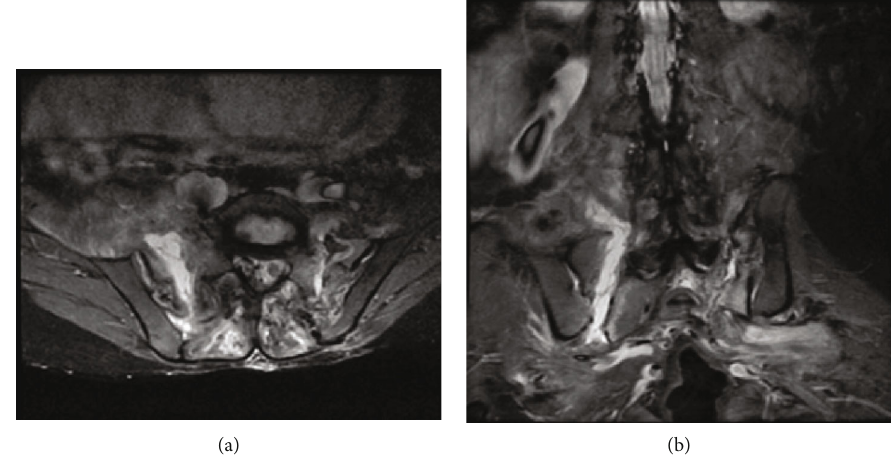
Figure 3: MRI showed an extensive oedema of the posterior paraspinal muscles bilaterally from L4 to S2 levels and di ff use marrow oedema of the sacrum. A large collection in the right posterior paraspinal muscles tracking inferiorly and anteriorly through a large bony defect in the right half of the sacrum seen in the axial (a) and coronal (b) views. There are bilateral spinal-pelvic fractures and